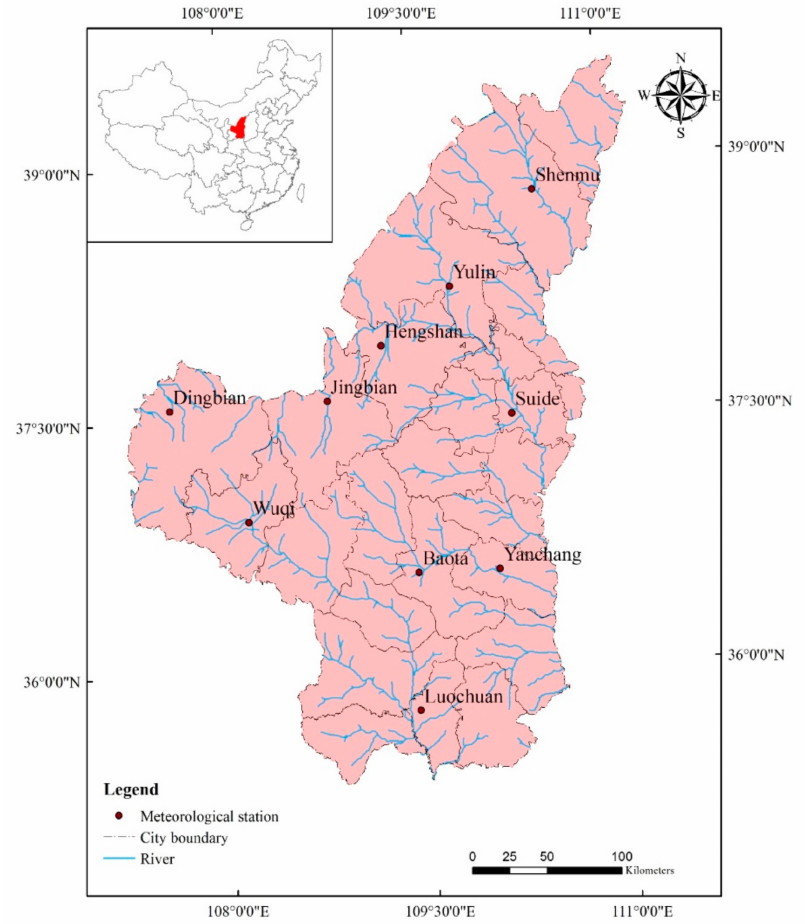
Figure 1. The spatial distribution of 10 meteorological stations in Northern